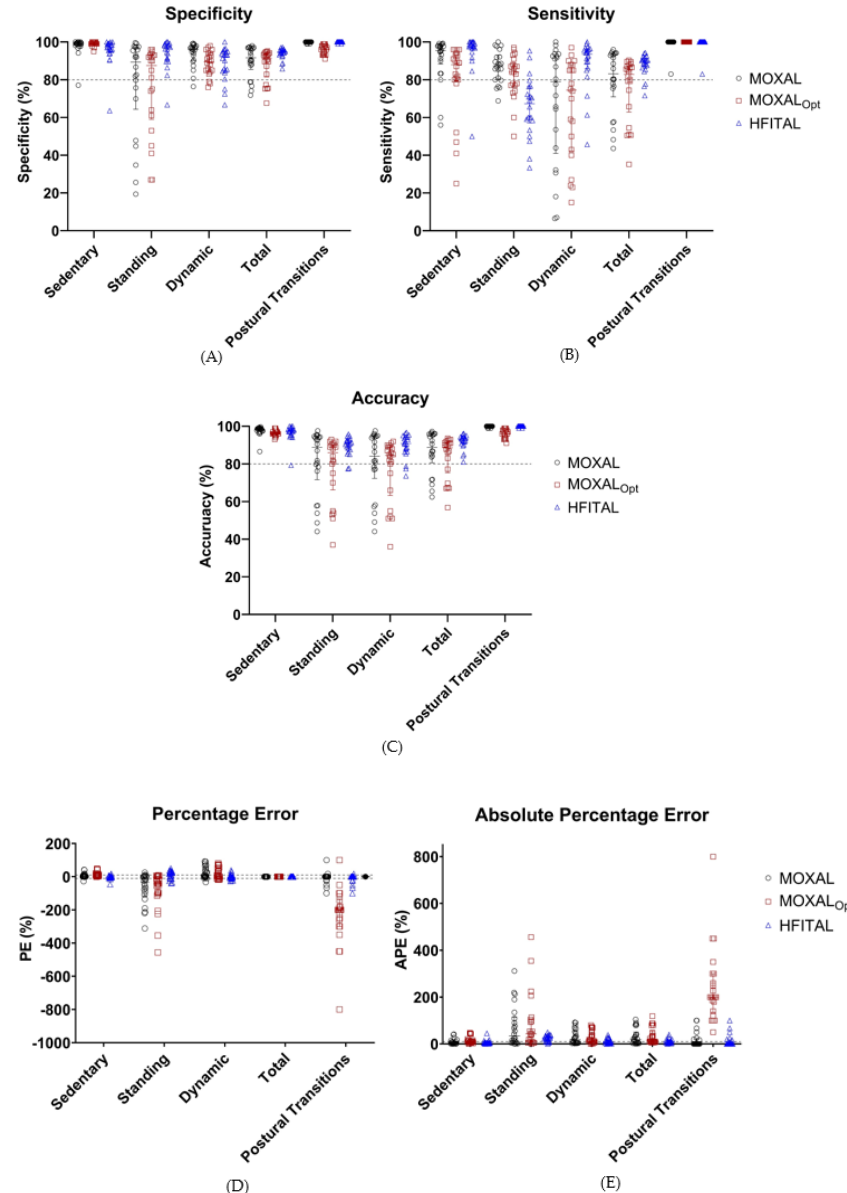
Figure 4. Performance metrics (%, Sensitivity ( A ), specificity ( B ), accuracy ( C ), percentage error ( D ), and absolute percentage error ( E )) of the classification of activities by MOXAL, MOXAL Opt , and HFITAL within the optimization group. All individual values are shown. Acceptable limits are represented by dashed lines. MOXAL is represented in black, MOXAL Opt in brown, and HFITAL in blue. (MOXAL = adjustable classification algorithm validated in community-dwelling healthy elderly persons with an upper leg wear location, used as the starting point for the optimization process. MOXAL Opt = classification algorithm after optimization of three adjustable parameter settings of MOXAL to reduce the absolute percentage error for total activity. HFITAL = classification algorithm after additional modifications were introduced to MOXAL regarding the decision tree and the calculation of the amount of physical activity).